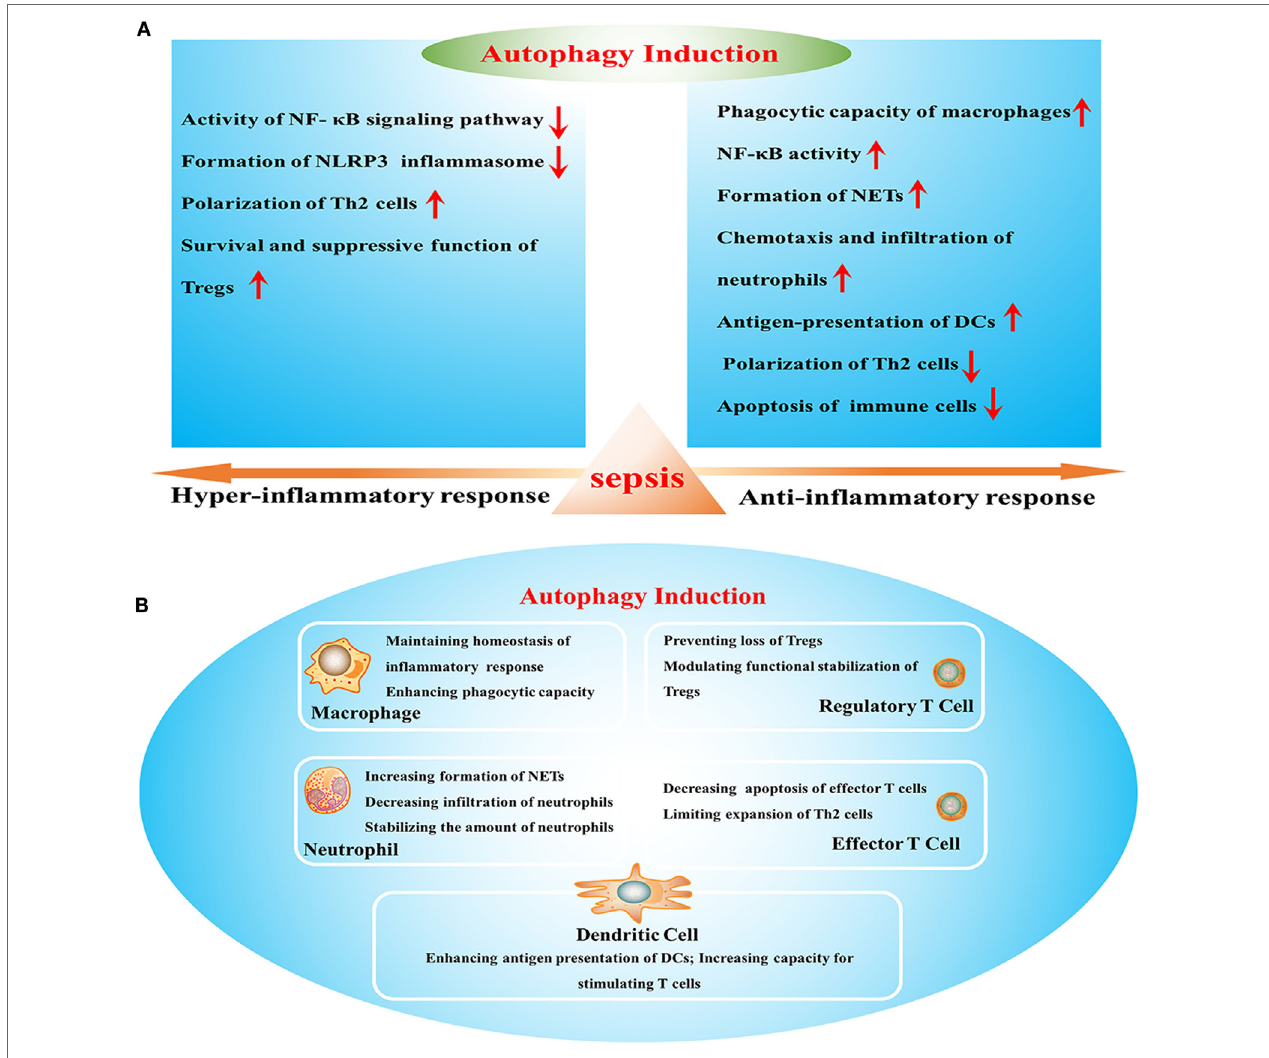
FiGURe 1 | The effects of autophagy induction on sepsis­induced immune dysfunction. (A) Effects of autophagy in various stages of sepsis. (B) The role of autophagy induction in the function of multiple immune cells. NF­ κ B, nuclear factor kappa­light­chain­enhancer of activated B cells; NLRP3, Nod­like receptor family pyrin domain­containing 3; Tregs, regulatory T cells; NETs, neutrophil extracellular traps; DCs, dendritic